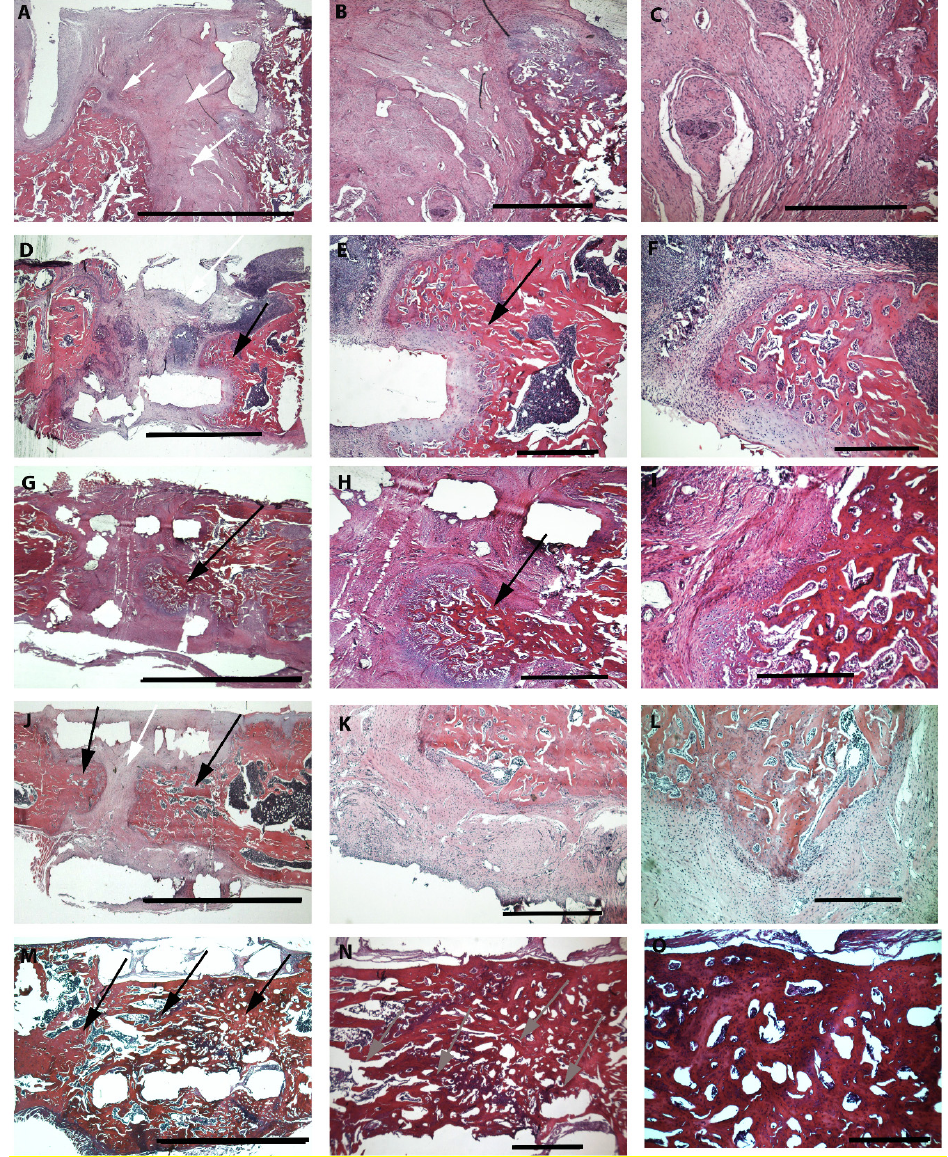
Figure 5. HE staining of various groups (8 weeks after surgery) under three different magnifications. First column overview—scale bar 5 mm; second column—30 times magnification—scale bar 1 mm; third column—75 times magnification—scale bar 500 µm. Group 1—no implant— A – C ; 2—PLA cylinder alone— D – F ; 3—PLA cylinder + collagen type I— G – I ; 4—PLA cylinder + collagen type I + SDF-1— J – L ; 5—PLA cylinder + collagen type I + BMP-7— M – O . White arrows indicate regions with connective tissue, black arrows indicate bone growth, and grey arrows show holey structures of the bone tissue.